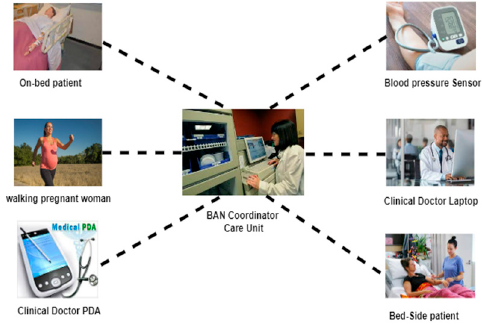
Figure 2. Example of a body sensor network [22].